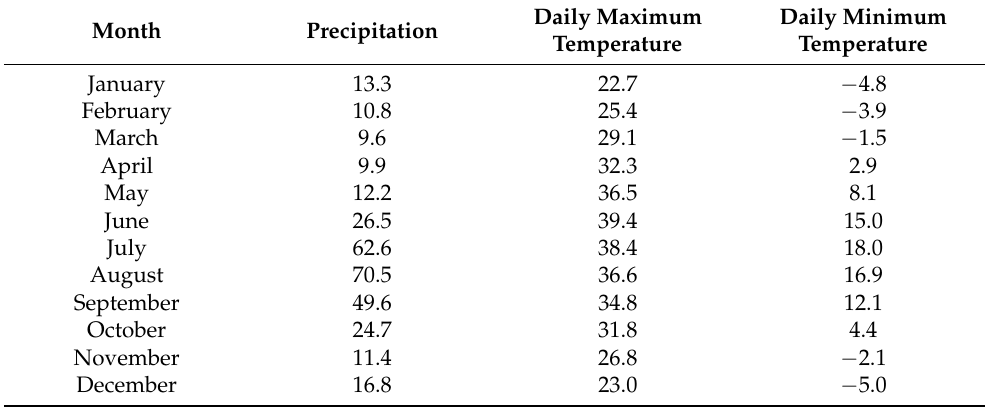
Table 1. Average monthly total precipitation (mm), daily maximum temperature ( ◦ C), and daily mini- mum temperature ( ◦ C) for 1 January 2007 to 24 December 2022 near the city of Ahumada, Chihuahua, Mexico. (Source: https://power.larc.nasa.gov/data-access-viewer/; accessed on 10 December 2022) Daily Maximum Daily Minimum Month Precipitation Temperature